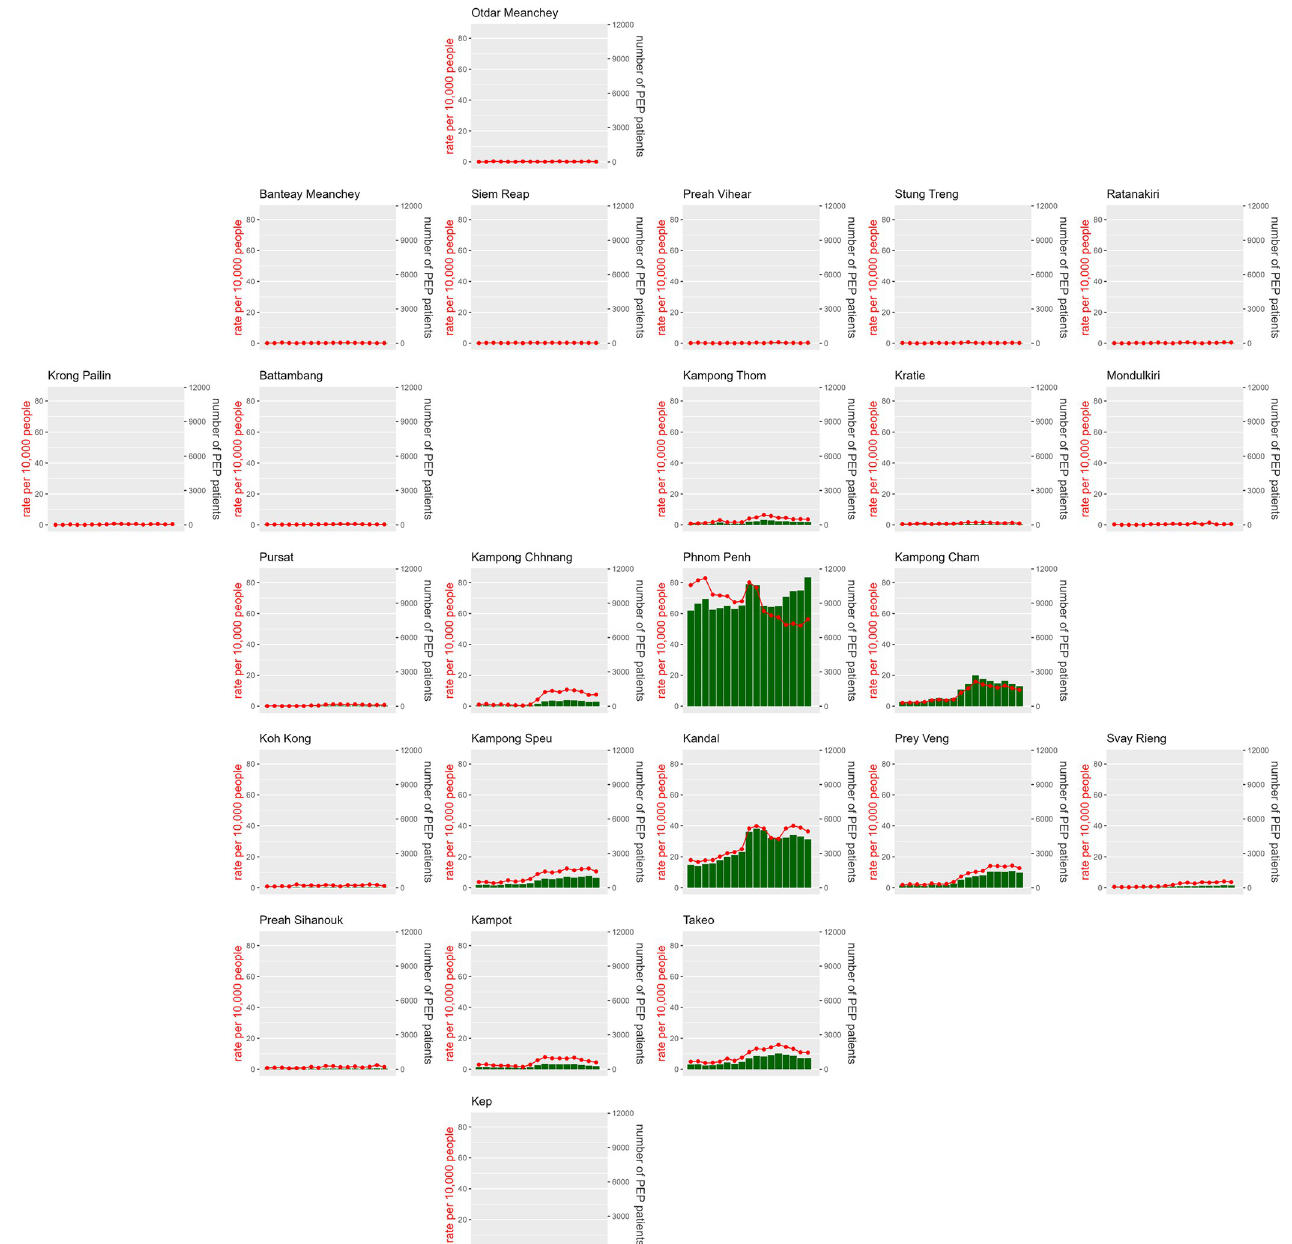
Fig 2. Time series of PEP patients numbers and rates by province. Red curves represent rates per 10,000 people and histogram bars represent absolute numbers.